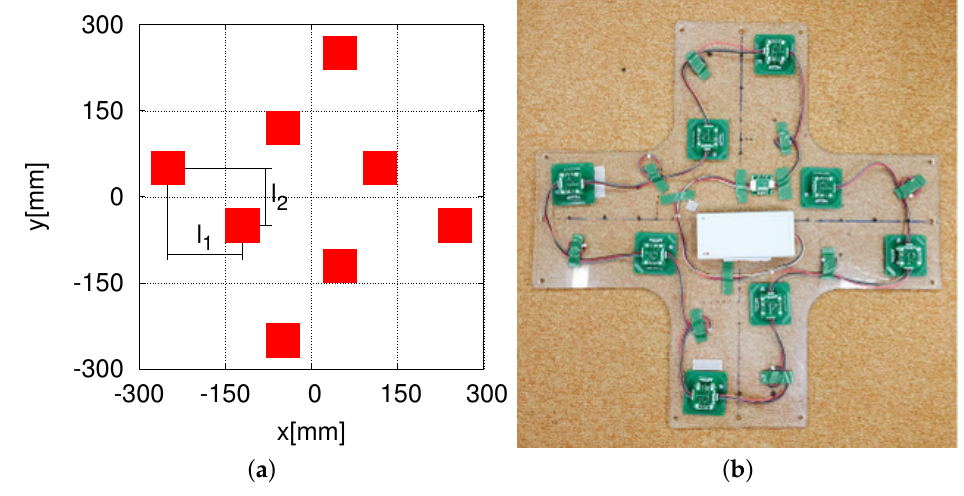
Figure 6. A new scheme for eight RFID readers. ( a ) Arrangement; ( b ) installation.